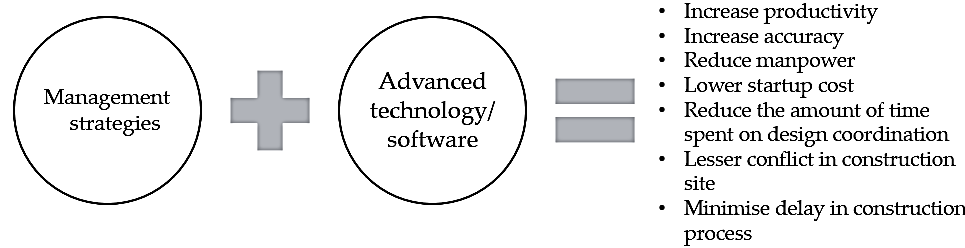
Figure 6. BIM design coordination process in the construction industry will benefit significantly from a suitable combination of management methods and advanced technology.